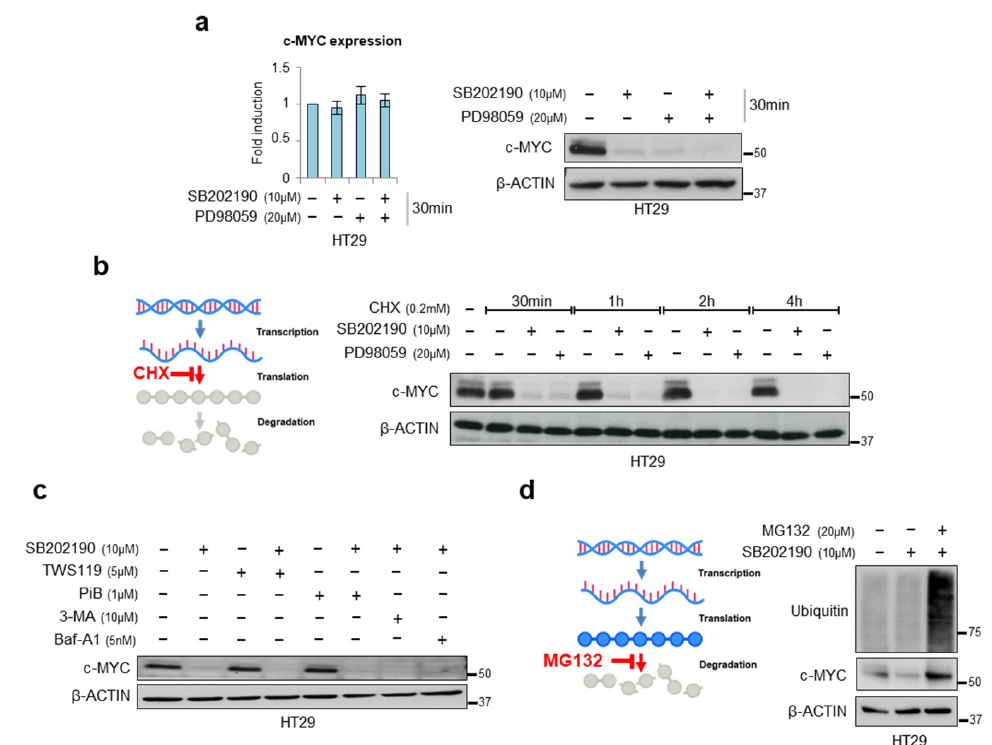
Figure 2. p38 α stabilizes c-MYC protein. ( a ) Left panel: RT-PCR analysis of c-MYC mRNA levels in HT29 cells treated with SB202190 (10 µ M) and/or PD98059 (20 µ M) for 30 min. Right panel: Immunoblotting showing c-MYC protein levels in HT29 cells treated with SB202190 (10 µ M) and/or PD98059 (20 µ M) for 30 min. ( b ) Immunoblotting showing c-MYC protein levels in HT29 cells treated with the protein biosynthesis inhibitor cycloheximide (0.2 mM), whose action is schematically represented on the left, and SB202190 (10 µ M) or PD98059 (20 µ M) for 0 to 4 h. ( c ) Immunoblotting showing c-MYC protein levels in HT29 cells treated for 8 h with different inhibitors, i.e., the GSK3 β inhibitor TWS119 (5 µ M), the PIN1 inhibitor PiB (1 µ M), the autophagic inhibitors 3-methyladenine (10 µ M) and bafilomycin (5 nM), in combination or not with SB202190 (10 µ M). ( d ) Immunoblotting showing ubiquitin and c-MYC protein levels in HT29 cells treated for 5 h with SB202190 (10 µ M), with or without the proteasome inhibitor MG132 (20 µ M), whose action is schematically represented on the left, for 1 h. CHX: cycloheximide, 3MA: 3-methyladenine, Baf-A1: bafilomycin. β -actin was used as a loading control. The presented results are representative of at least three independent experiments. Detailed information about Western Blot can be found at supplementary materials.